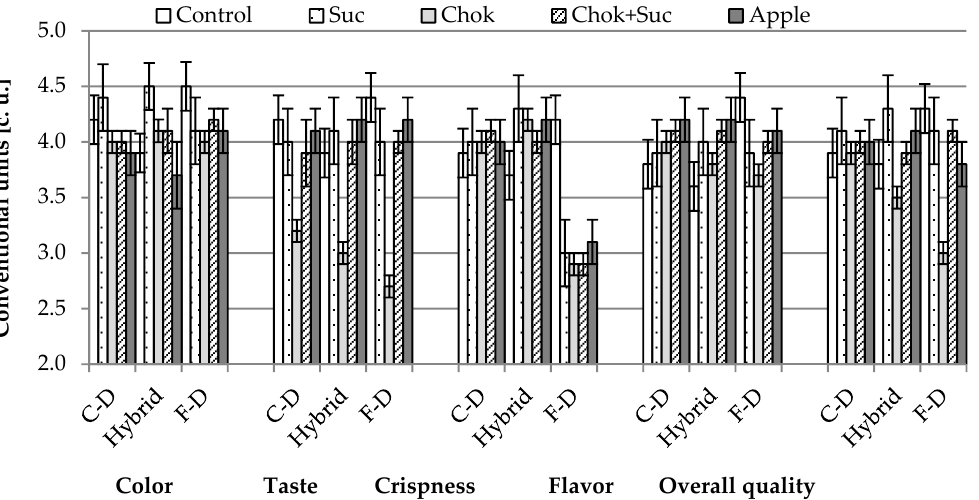
Figure 7. Influence of the type of osmotic solution and drying method on sensory properties of quince fruit chips—coding the type of drying method as given in the experimental procedures.